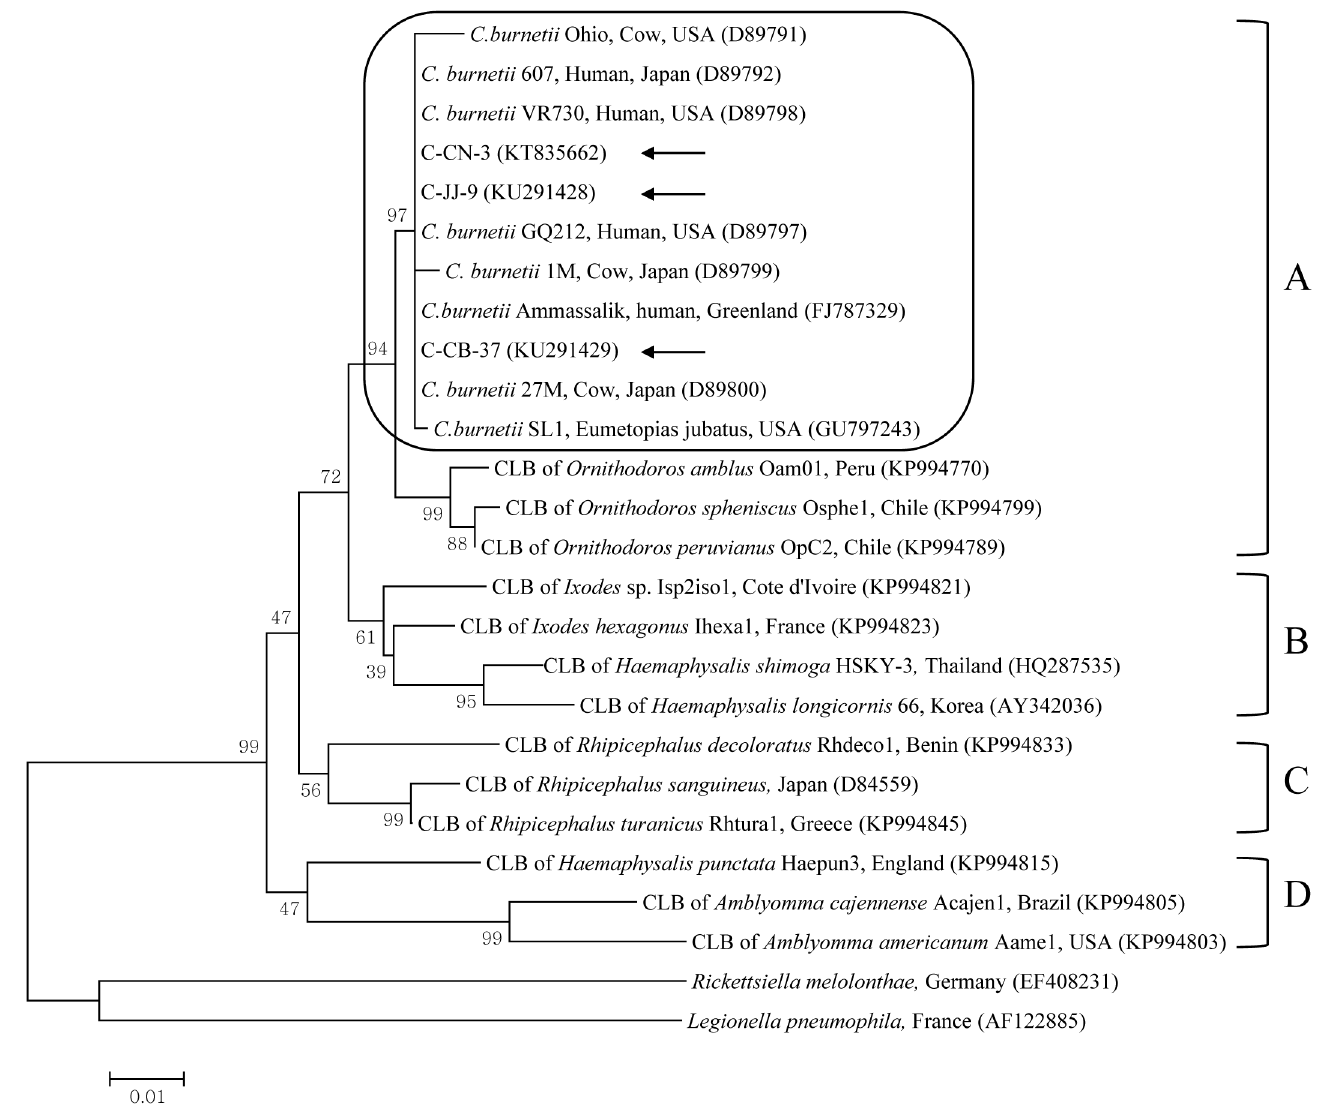
Fig 3. Phylogenetic tree constructed using the maximum-likelihood method based on the 16S rRNA sequences of the genus Coxiella . Coxiellaburnetii sequencesfrom this study are marked by arrows. C . burnetii species are groupedin a square. The four clades of the genus Coxiella are labeledA to D. Accession numbers of other sequencesfrom GenBankare shown with the sequencenames and countries. Numbers on the branches indicatebootstrap support (1,000 replicates). Scale bar is the phylogenetic distancein the sequence.CLB = Coxiella -like bacteria.